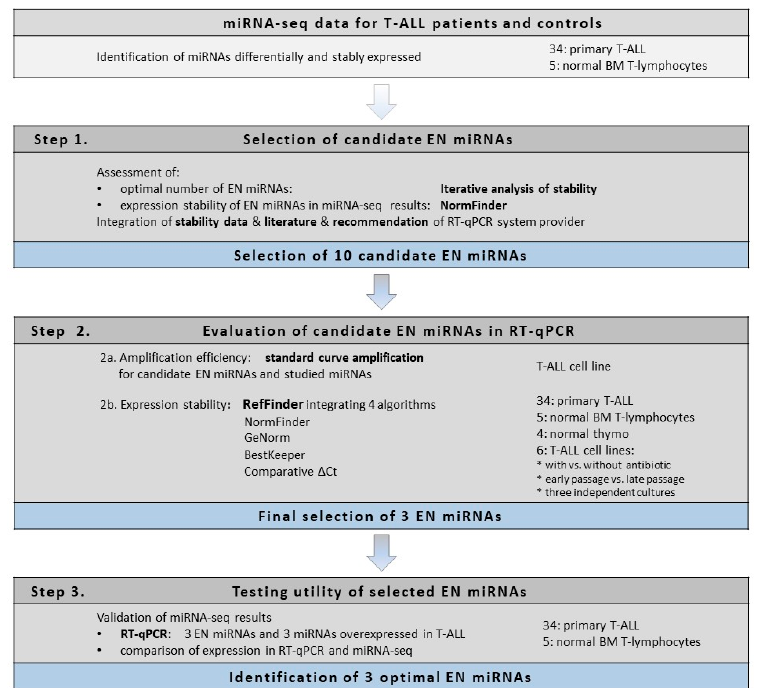
Figure 1. Workflow diagram illustrating strategy for identification of endogenous normalizer microRNAs (miRNAs) for RT-qPCR. BM, bone marrow; EN, endogenous normalizer; miRNA-seq, miRNA sequencing; T-ALL, T-cell acute lymphoblastic leukemia; thymo, thymocytes.